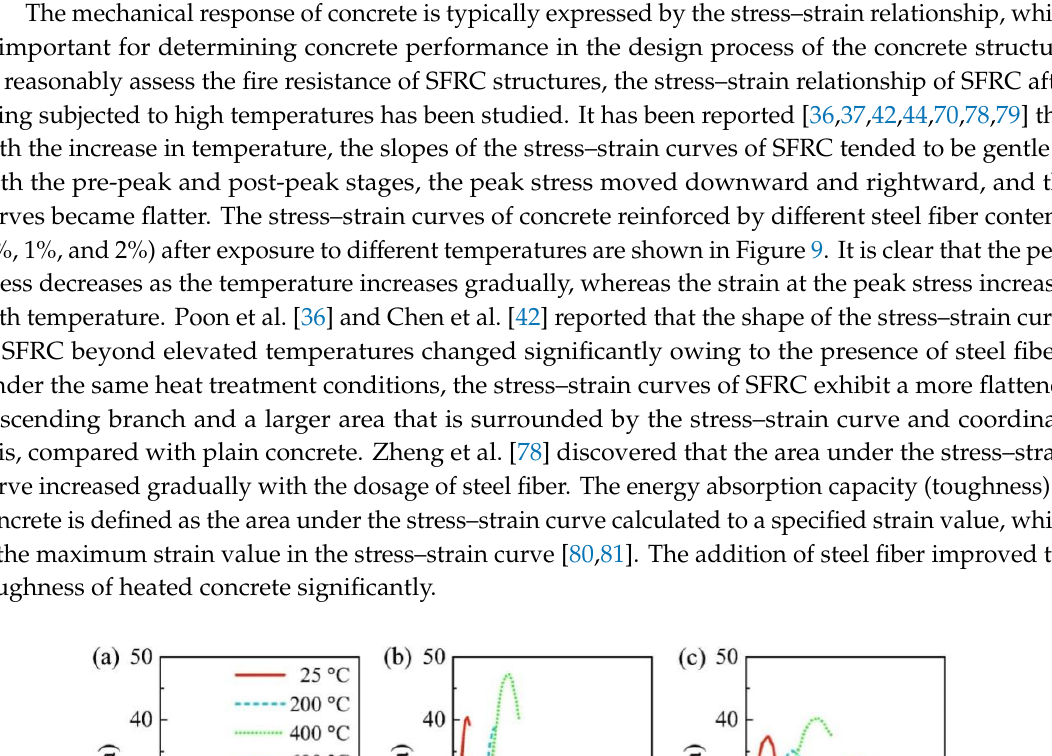
Figure 8. Effects of exposure temperature and steel fiber content on unstable fracture toughness [13].